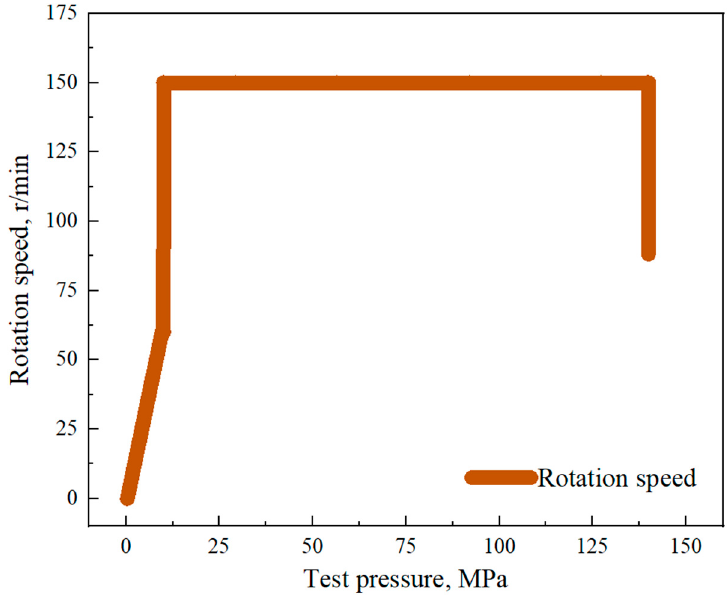
Figure 17. Rotation speed vs. test pressure.